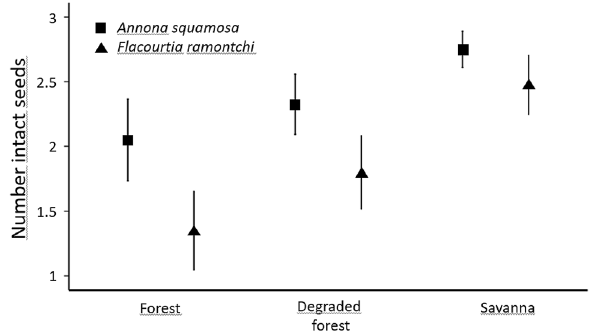
Figure 2. Average number of Annona squamosa and Flacourtia ramontchi seeds left intact at the experimental plots (N = 40 per vegetation formation) after 14 days. Though the data deviate from normality, values are means and 95% confidence intervals to illustrate differences between groups better than it would be possible with medians and quartiles.